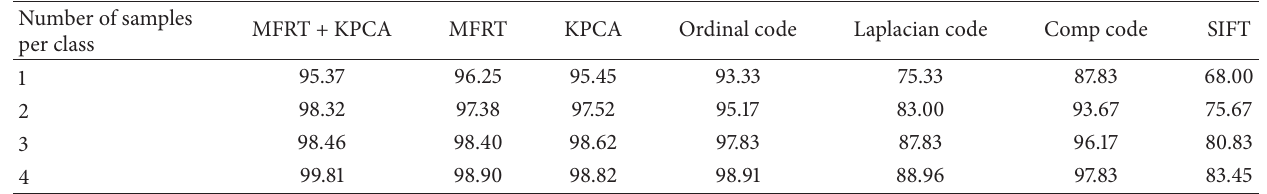
Table 2: Accuracy measures from CASIA right hand multispectral palm print image.